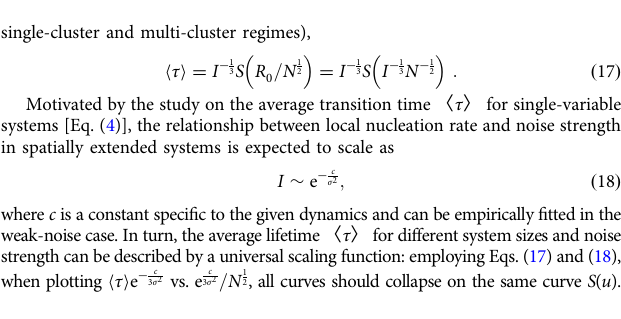
Fig. 7 Average lifetime 〈 τ 〉 and the scaling results for three diffusion models. The diffusion rate is set as R = 0.02. a – d harvesting model, r = 1 and K = 10; e – h eutrophication model, a = 0.5 and r = 1; i – l vegetation model, r = 1, r = 0.5, h = 0.2. a , e , and i are the resilience diagrams. These models v v exhibit alternative stale states for a β ∈ (1.79, 2.60), e β ∈ (0.86, 6.35), and i β ∈ (2.59, 3.64). The arrows represent transitions from the low stable state to the high stable state. In simulation, the bifurcation parameter β takes values of 1.80, 6.00, 2.60 for a , e , and i , respectively. For b , f , and j , the system starts from the undesired states x L , and the average lifetime 〈 τ 〉 changes with N and σ . For e , g , and k , the system starts from the undesired states x L , the lifetimes of two clusters and the crossover are shown in the scaling form. For d , h , and l , the system starts from the prepared metastable states, the lifetimes of two clusters and the crossover are shown in the scaling